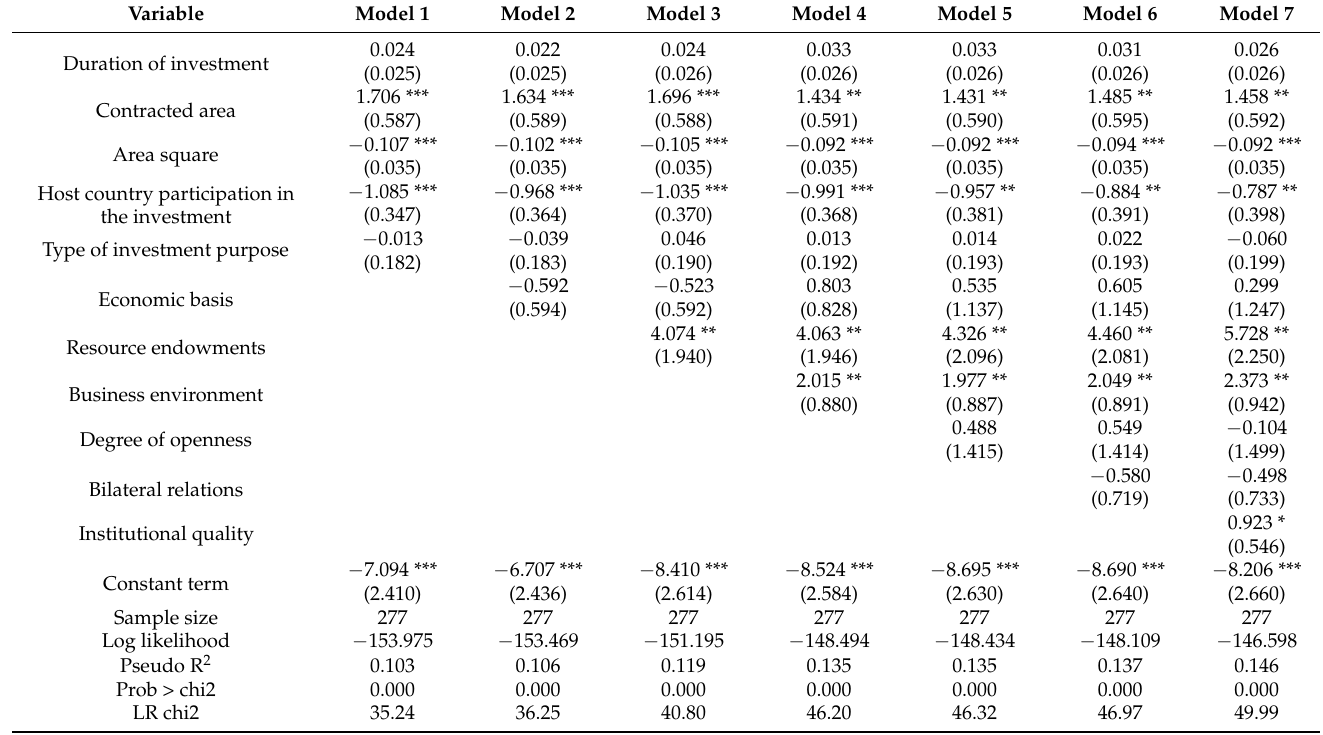
Table 6. Factors influencing the success of China’s overseas arable land